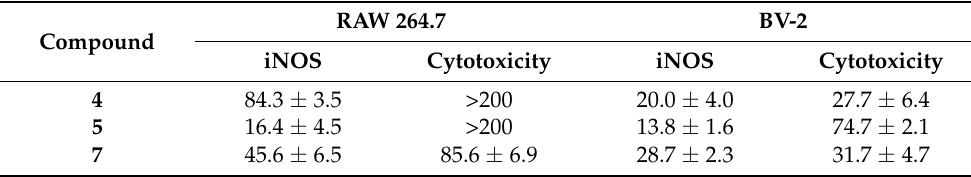
Table 3. IC 50 values ( µ M) d of compounds 4 , 5 , and 7 on inhibition of NO production in LPS-IFN- γ - induced RAW 264.7 macrophages and BV-2 microglial